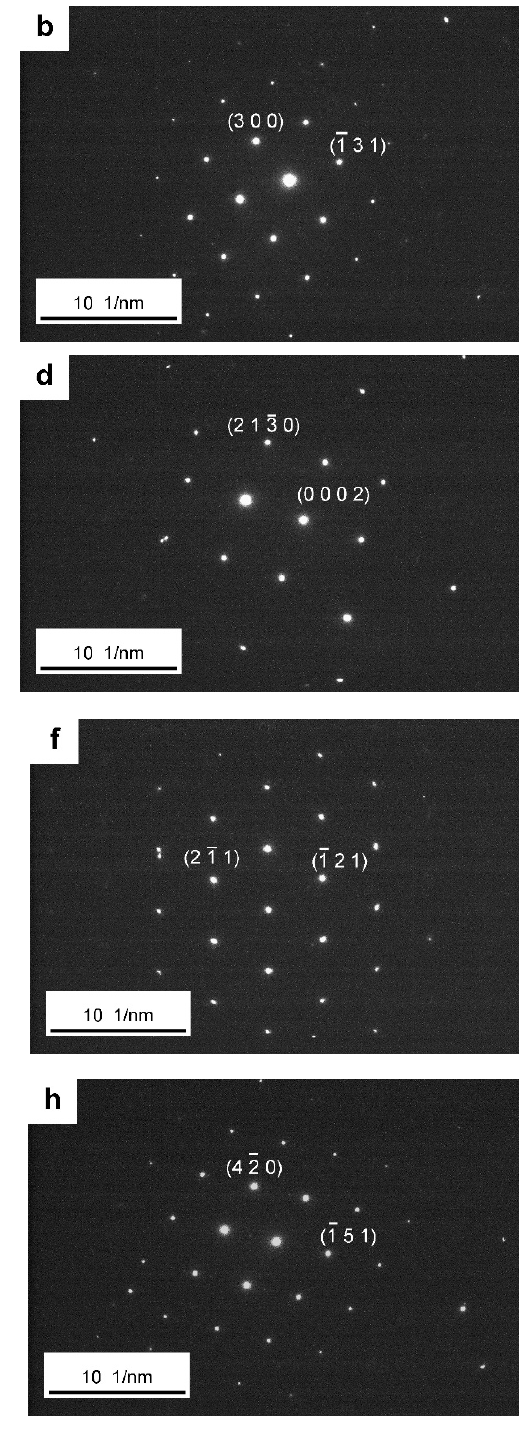
Figure 5. TEM images showing the presence of different alloy carbides tempered at 600 °C: ( a ) the morphology of M 8 C 7 carbide (existing from 4 h to 24 h); ( b ) the corresponding SAD pattern for the particle in ( a ) consistent with the [0 − 3 9] zone axis of M 8 C 7 ; ( c ) the morphology of M 7 C 3 carbide (existing from 4 h to 24 h); ( d ) the corresponding SAD pattern for the particle in ( c ) consistent with the [ − 4 5 − 1 0] zone axis of M 7 C 3 ; ( e ) the morphology of M 23 C 6 carbide (existing from 16 h to 24 h); ( f ) the corresponding SAD pattern for the particle in ( e ) consistent with the [ − 1 − 1 1] zone axis of M 23 C 6 ; ( g ) the morphology of M 6 C carbide (solely existing for 24 h); ( h ) the corresponding SAD pattern for the particle in ( g ) consistent with the [ − 1 − 2 9] zone axis of M 6 C.